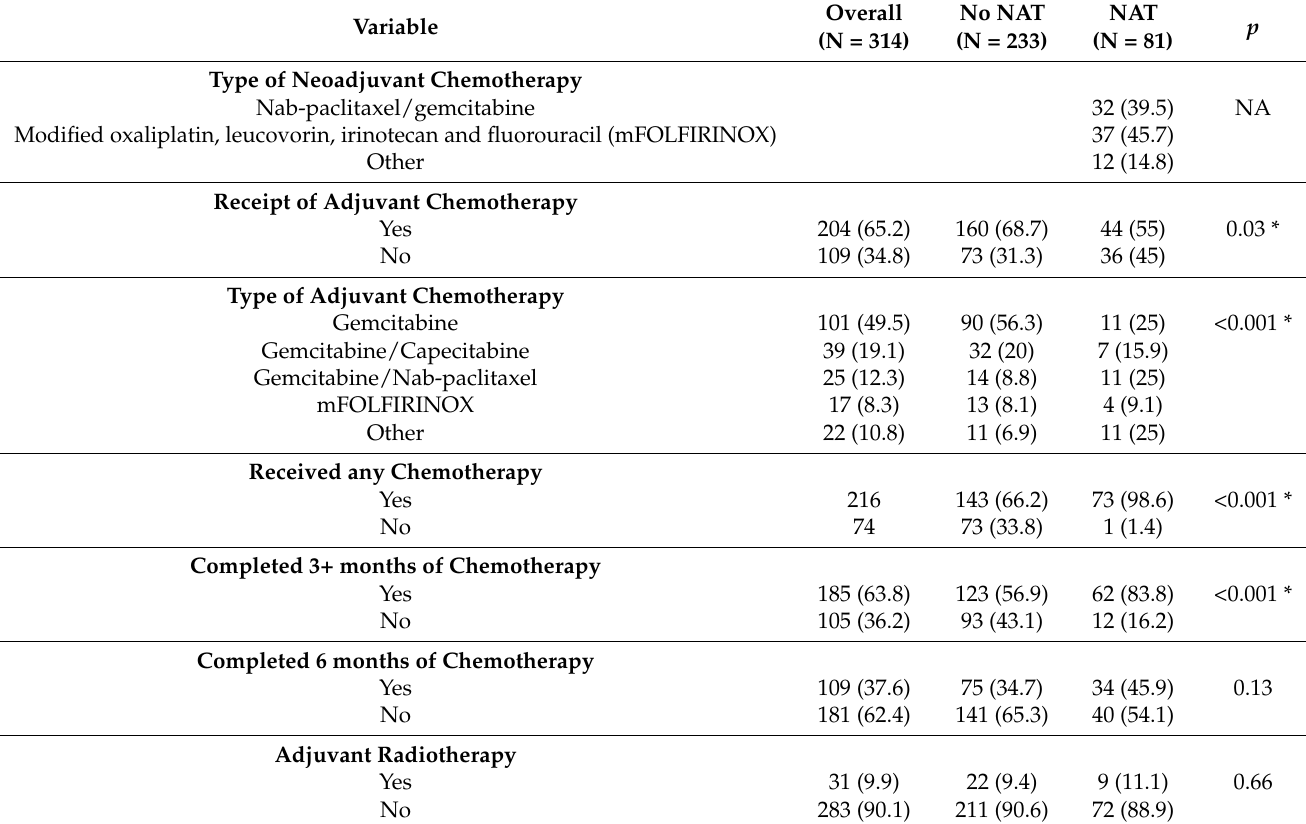
Table 2. Comparison of patterns of care between those who received NAT and those who did not.